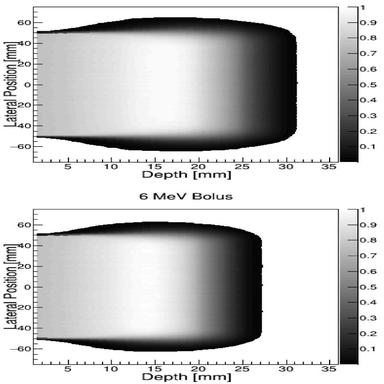
Absorbed dose distribution due to 6 MeV electron beams interacting with Water and BolusCM.